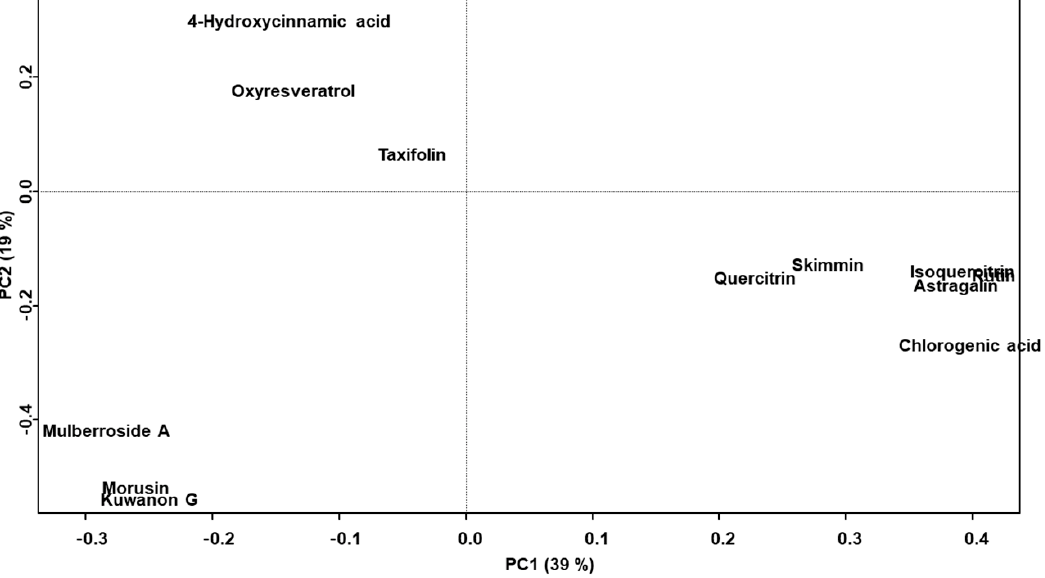
Figure 5. The principal component loading plot (PC1 vs. PC2) from the 12 marker compound contents of the Morus samples. PC1 and PC2 contributed to 39% and 19% of the total variance, respectively.